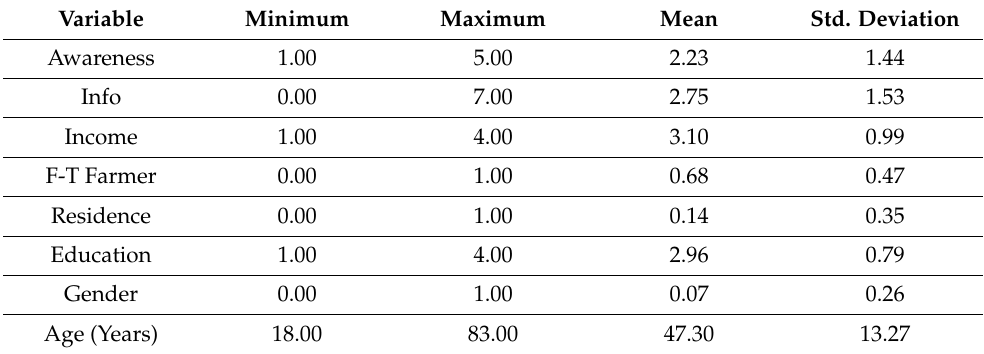
Table 4. Descriptive statistics of the variables of the factor categories “direct and wider social influences” and “farmers’